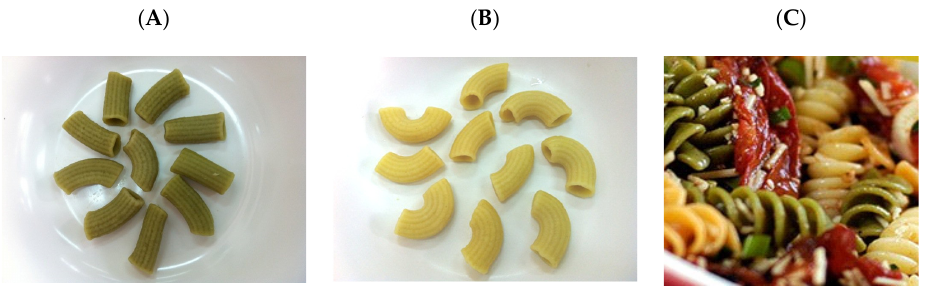
Figure 1. Cooked green tea extract-fortified macaroni ( A ), turmeric curcumin extract-fortified mac- aroni ( B ) and green tea extract/turmeric curcumin-fortified macaroni ( C ) products.